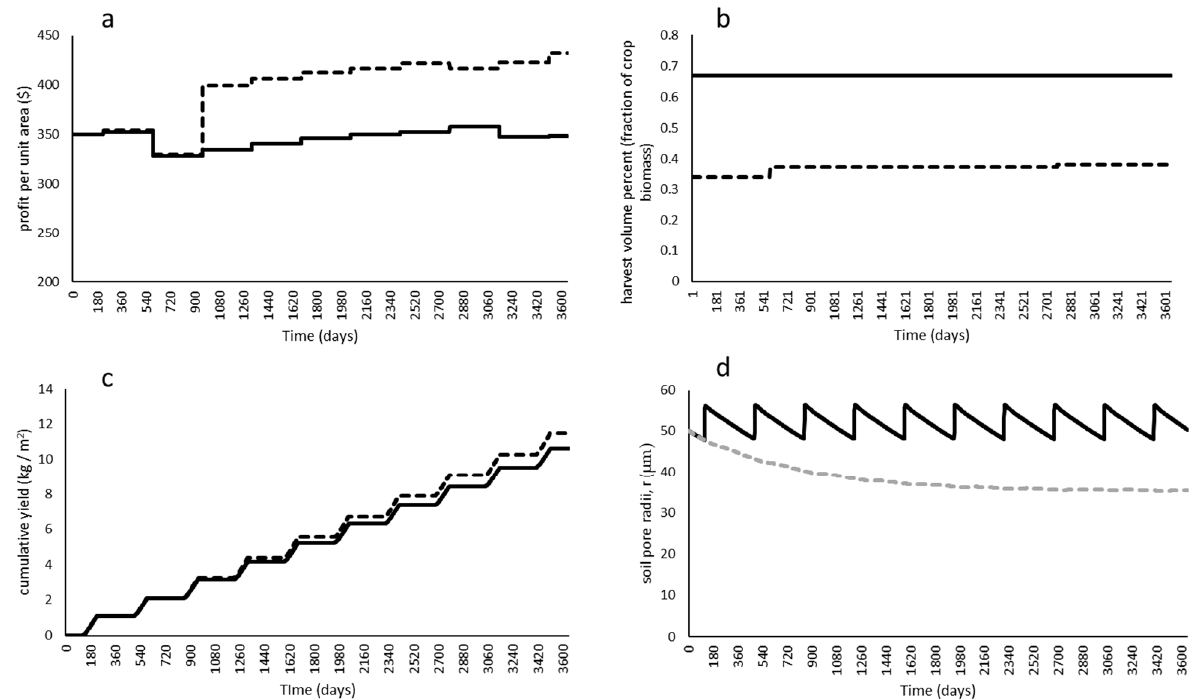
Figure 9. Economic and agronomic results from the tillage test switch from conventional tillage to no-tillage over 10 years (3650 days): (panel a ) crop profit per unit area ($) illustrating long-run equilibrium for the base case (solid line) and a long-run positive improvement in profit rate under no-tillage (dashed line); (panel b ) harvest volume percentage (i.e., the fraction of above-ground biomass removed during the act of harvest) under conventional (solid line) and no-tillage (dashed line) methods; (panel c ) cumulative yield over 10 years under conventional (solid line) and no-tillage (dashed line) methods; and (panel d ) mean soil pore radii under conventional (solid line) and no-tillage (dashed line)